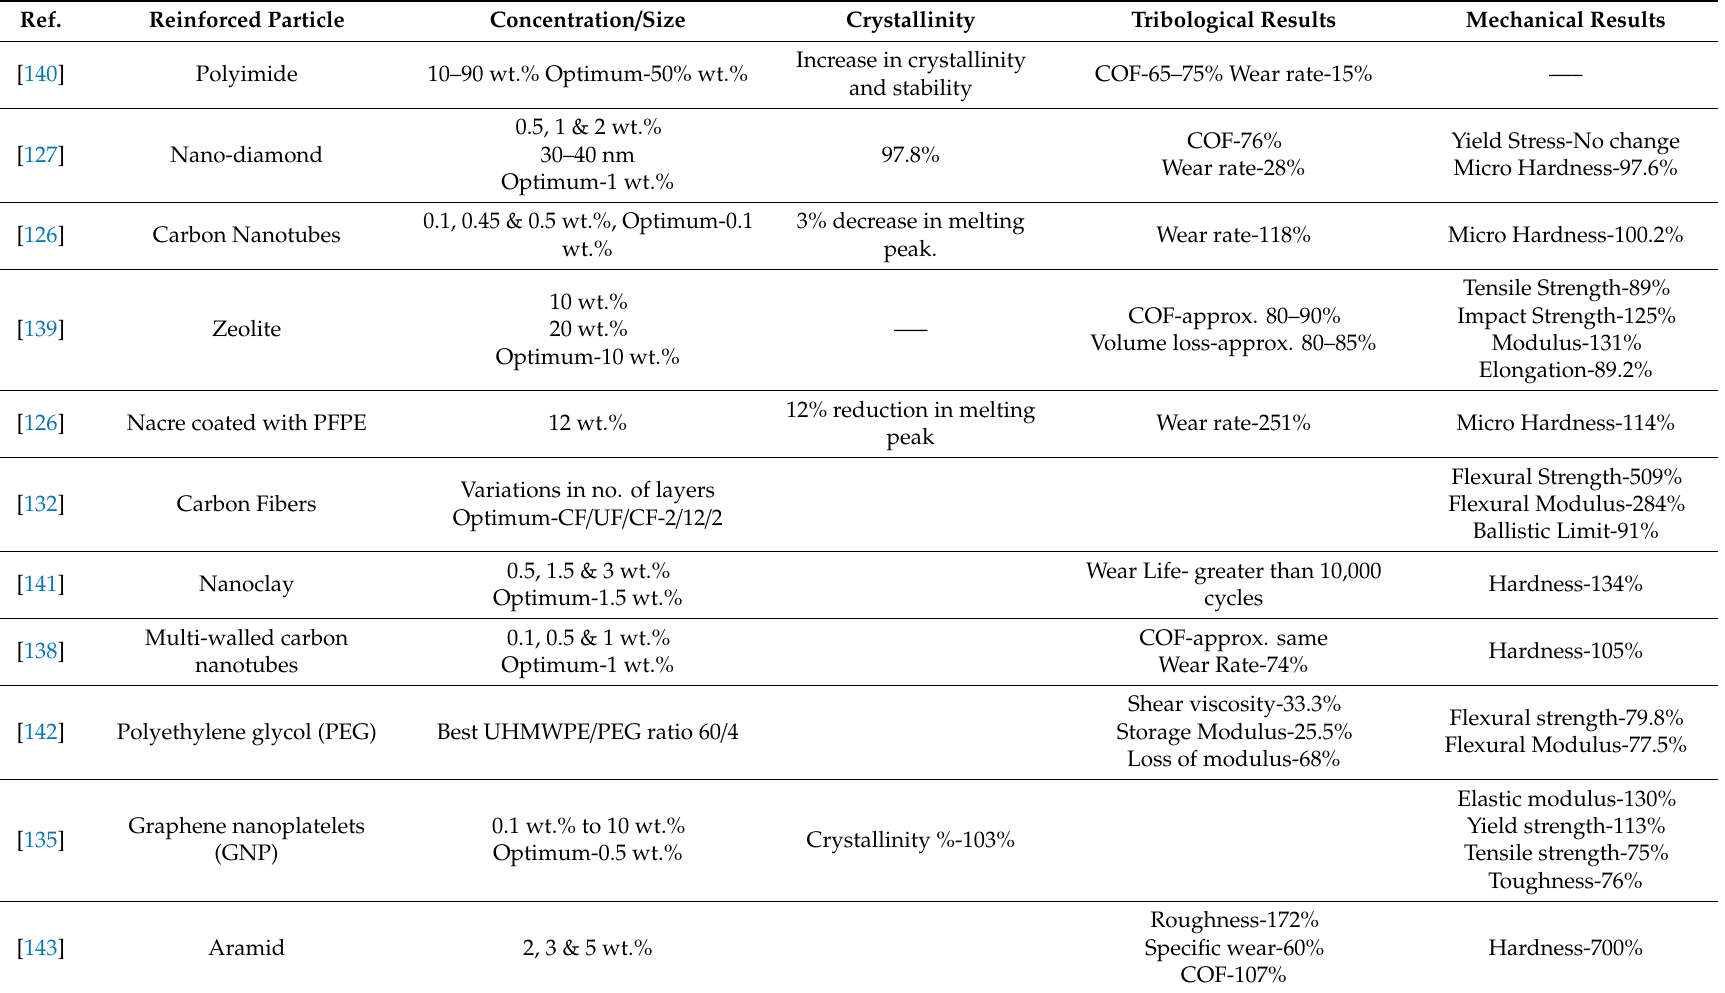
Table 3. Influence of particle or fibers reinforcement on crystallinity, tribological and mechanical results as compared to UHMWPE.